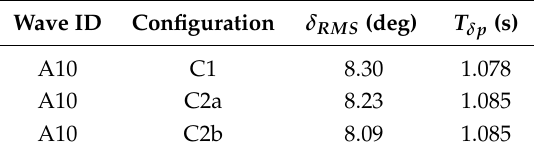
Table 13. Pitch motion spectral properties: 10-year